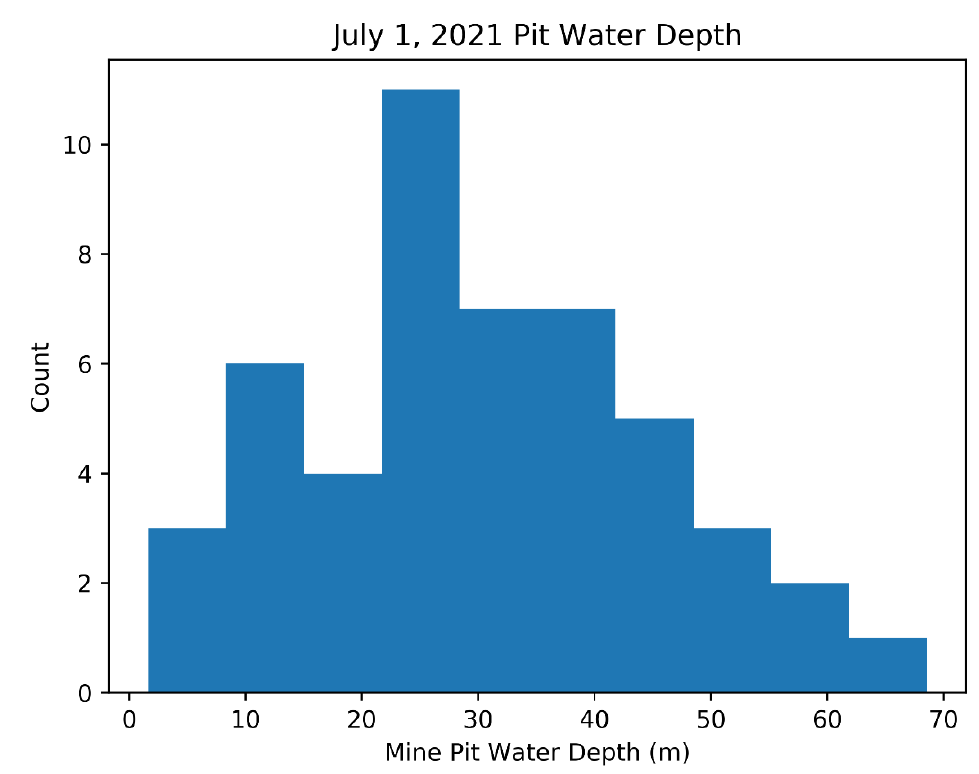
Figure 6. Predicted mine pit water depth two years after the cessation of mining using fifty parameter realizations from the IES analysis.